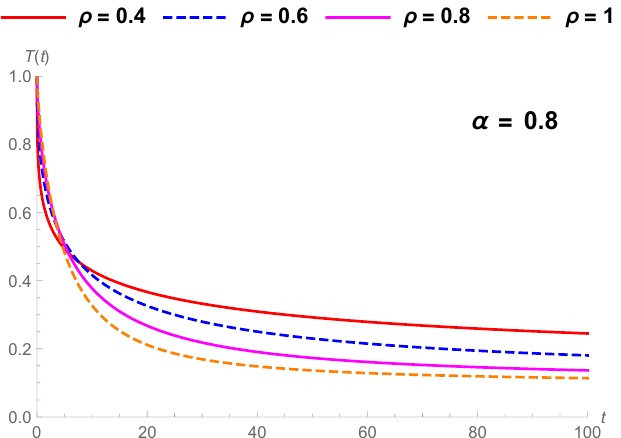
Figure 6. Comparison of drying kinetics with Lewis generalized fractional model under different ρ